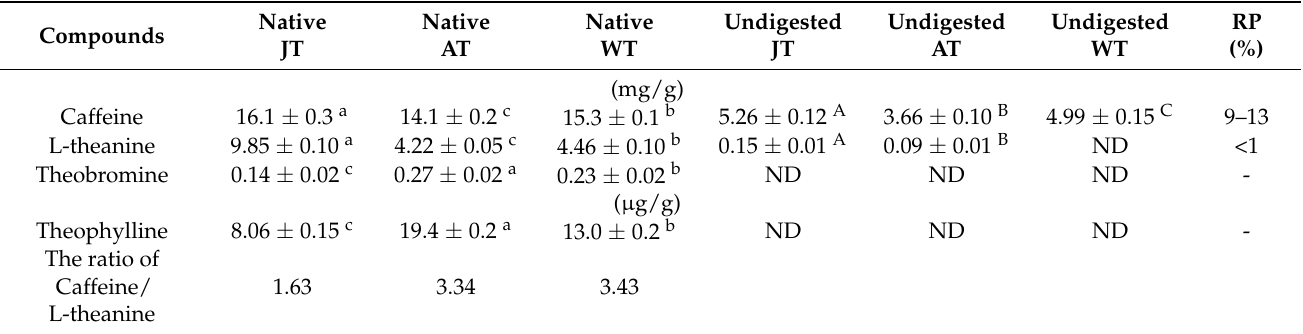
Table 3. Xanthine alkaloid and L-theanine compounds determined in native and undigested part of matcha